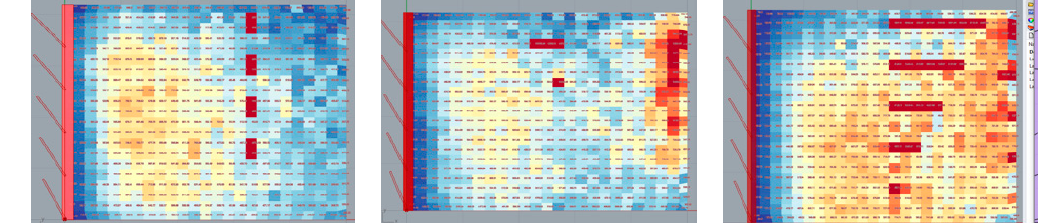
Figure 6. Improvement of the daylighting distribution by using IKF compared to the other systems.